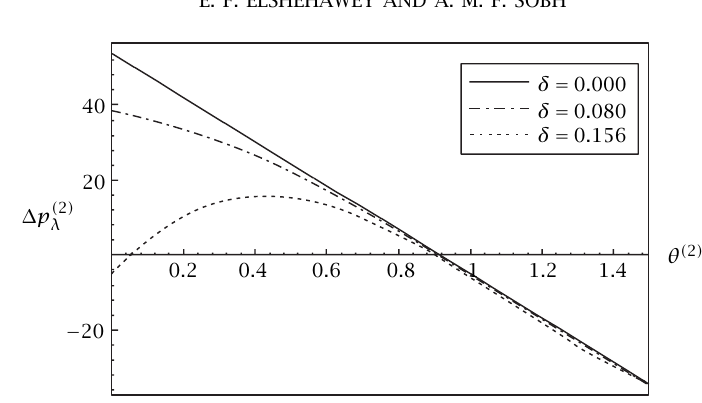
Figure 6.3 . The pressure rise versus flow rate at Re = 0 . 1, Wi = 0 . 08, and ϕ = 0 . 6.